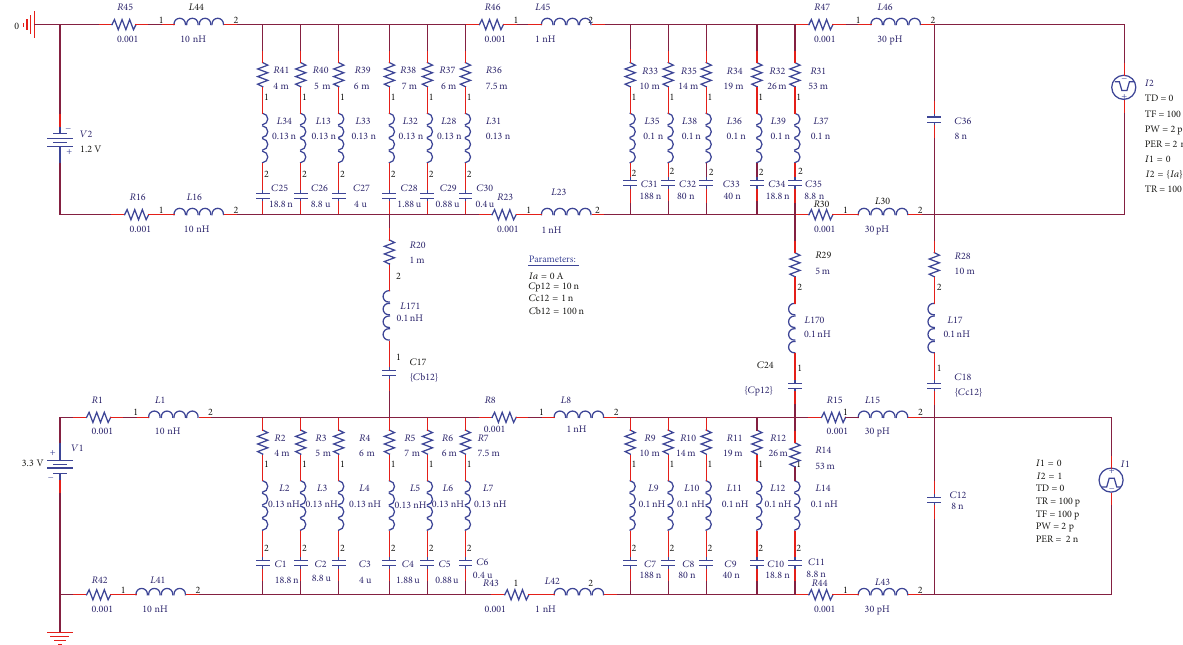
Figure 10: Lumped circuit of the PDN with dual supply voltages and two cores and with return